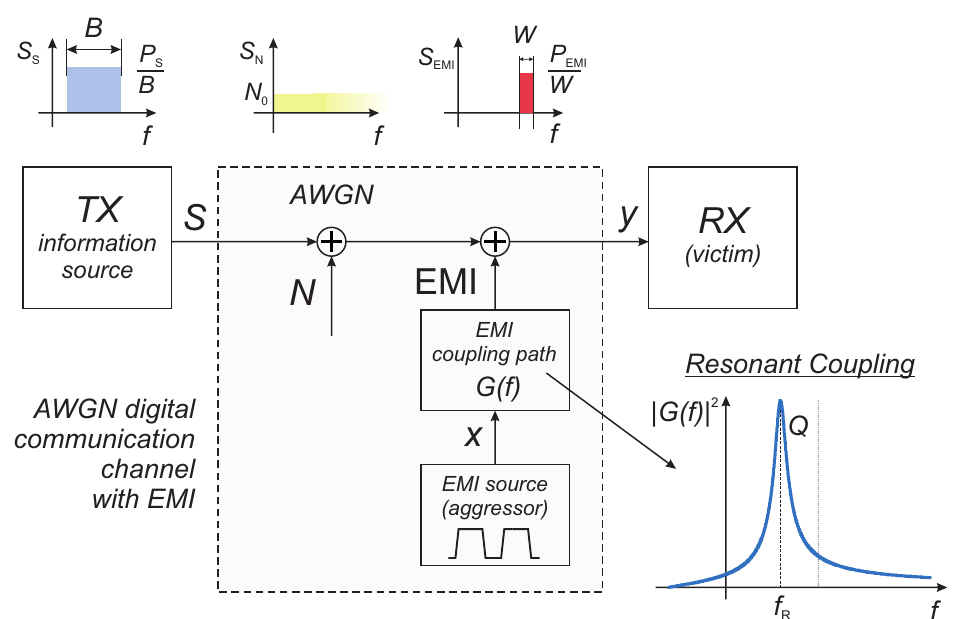
Figure 2. Digital communication channel with EMI resonant coupling: Block Diagram.